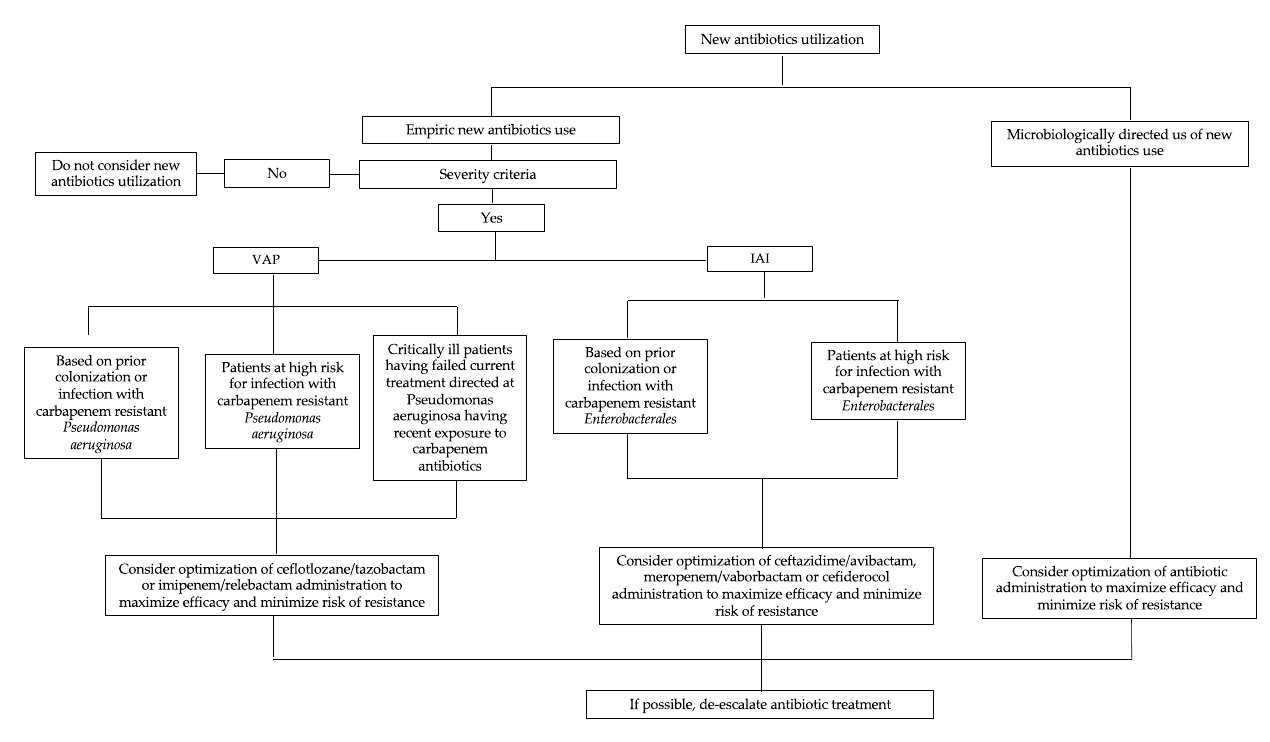
Figure 1. Proposed strategy for the clinical use of new antibiotics against Gram-negative bacteria. VAP: ventilator-associated pneumonia; IAI: intra-abdominal infection.